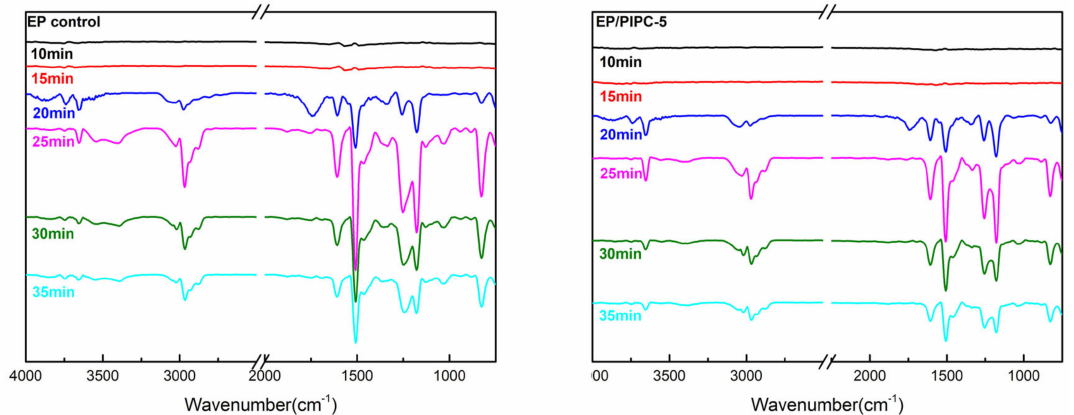
Figure 12. Infrared absorption spectra of EP control and EP / PIPC-5 at di ff erent time